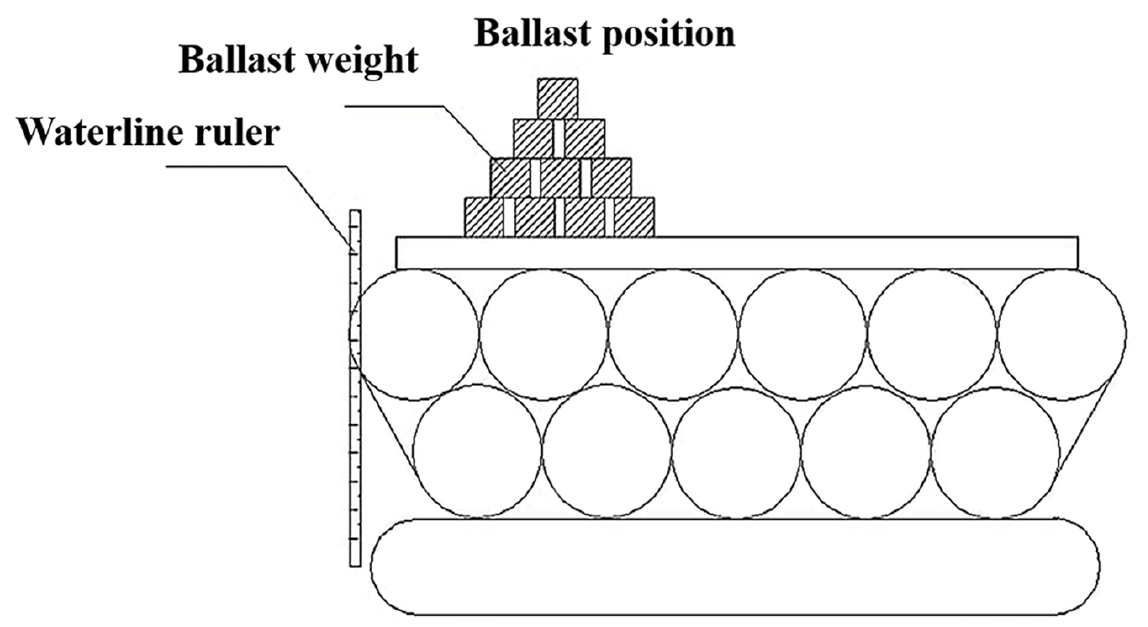
Figure 15. Ballast Diagram. Figure 16. Ballast Diagram. The data obtained from the experiment were statistically analyzed using an Excel table, and a relationship curve was fitted between the change of load under different working conditions and the change of pontoon draft. The Excel table with the data statistics, experimental results, and analysis results are presented below. The relationship between partial load and the draft are summarized in Table 5. Table 5. Record of the relationship between partial load and draft.